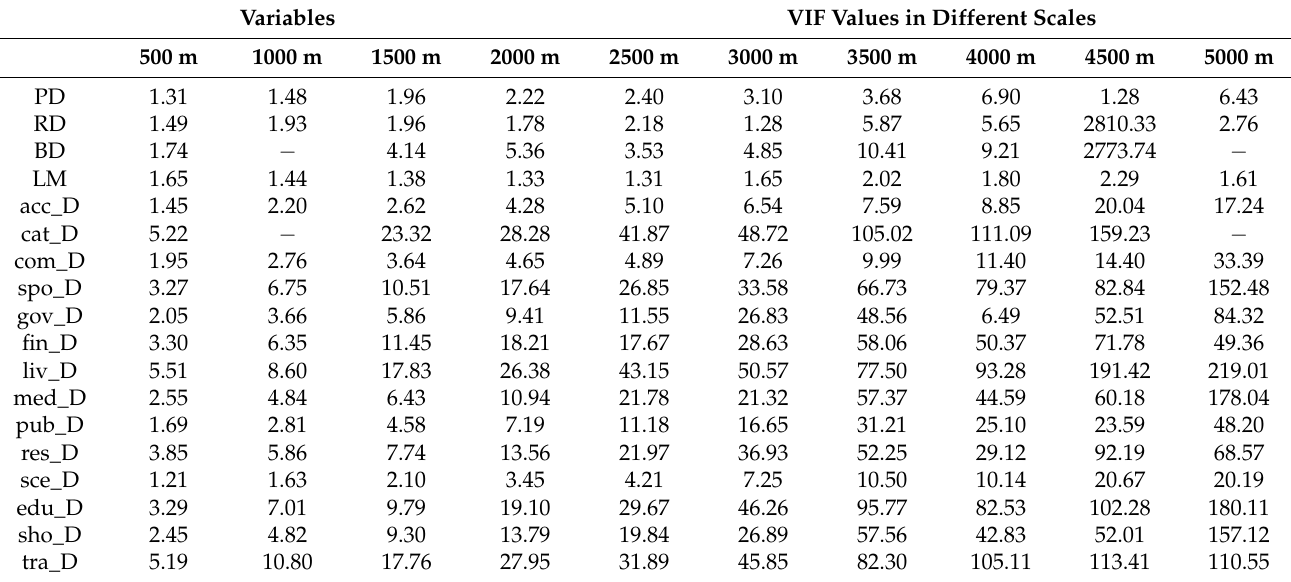
Table 3. The VIF values of initial variables in ten